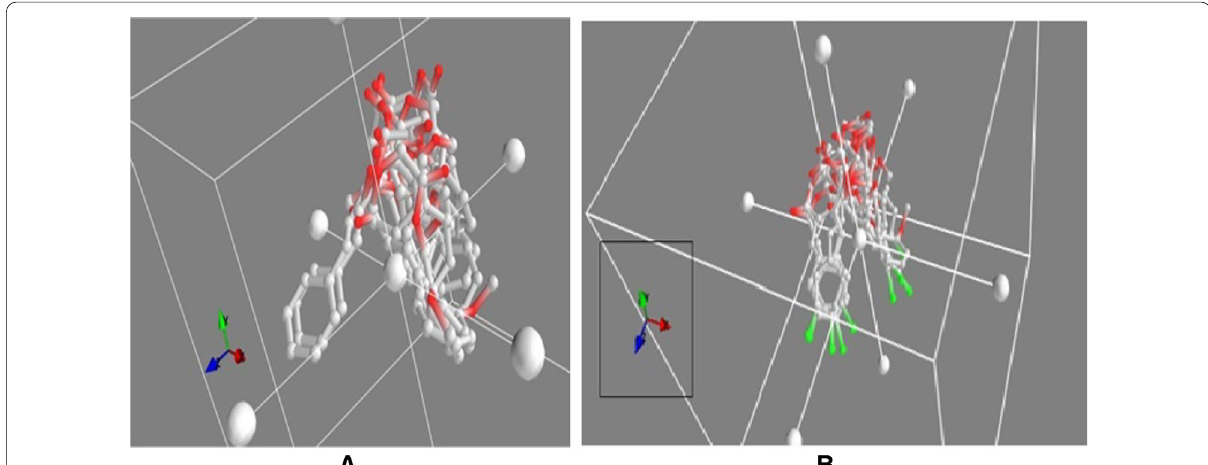
Fig. 4 Eight different structural conformations of T5 ( a ) and T8 ( b ) in binding pocket of lysyl oxidase (exhaustiveness was set at 8 before docking run)